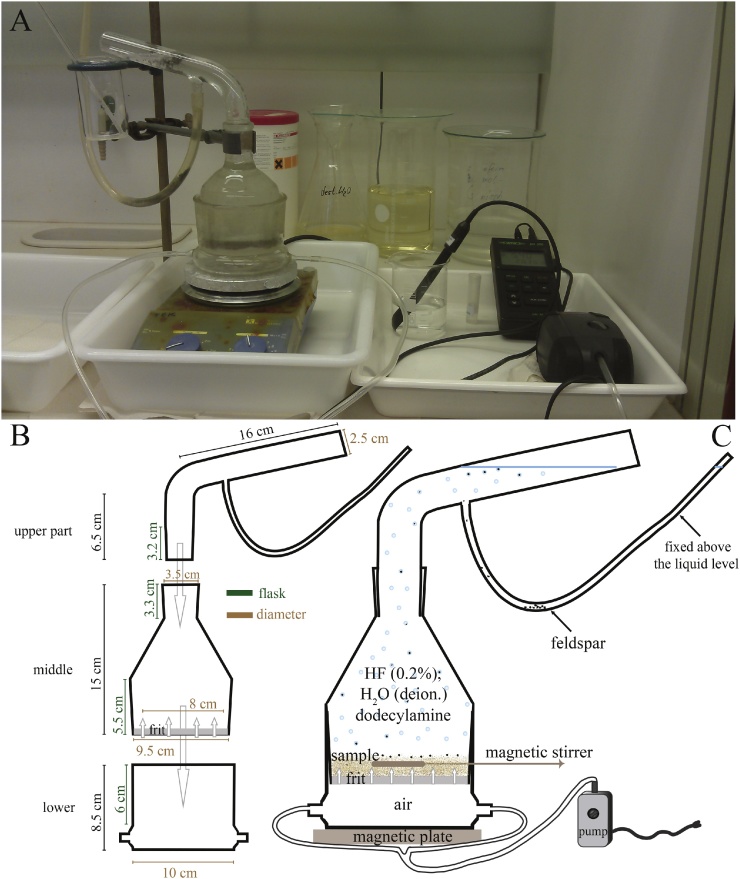
Flotation-cell design. (A) Photo of the flotation cell during operation; the devices on the right side are the pH meter and the air pump. (B) The three parts of the flotation cell with their dimensions. (C) The assembled flotation cell under operation.